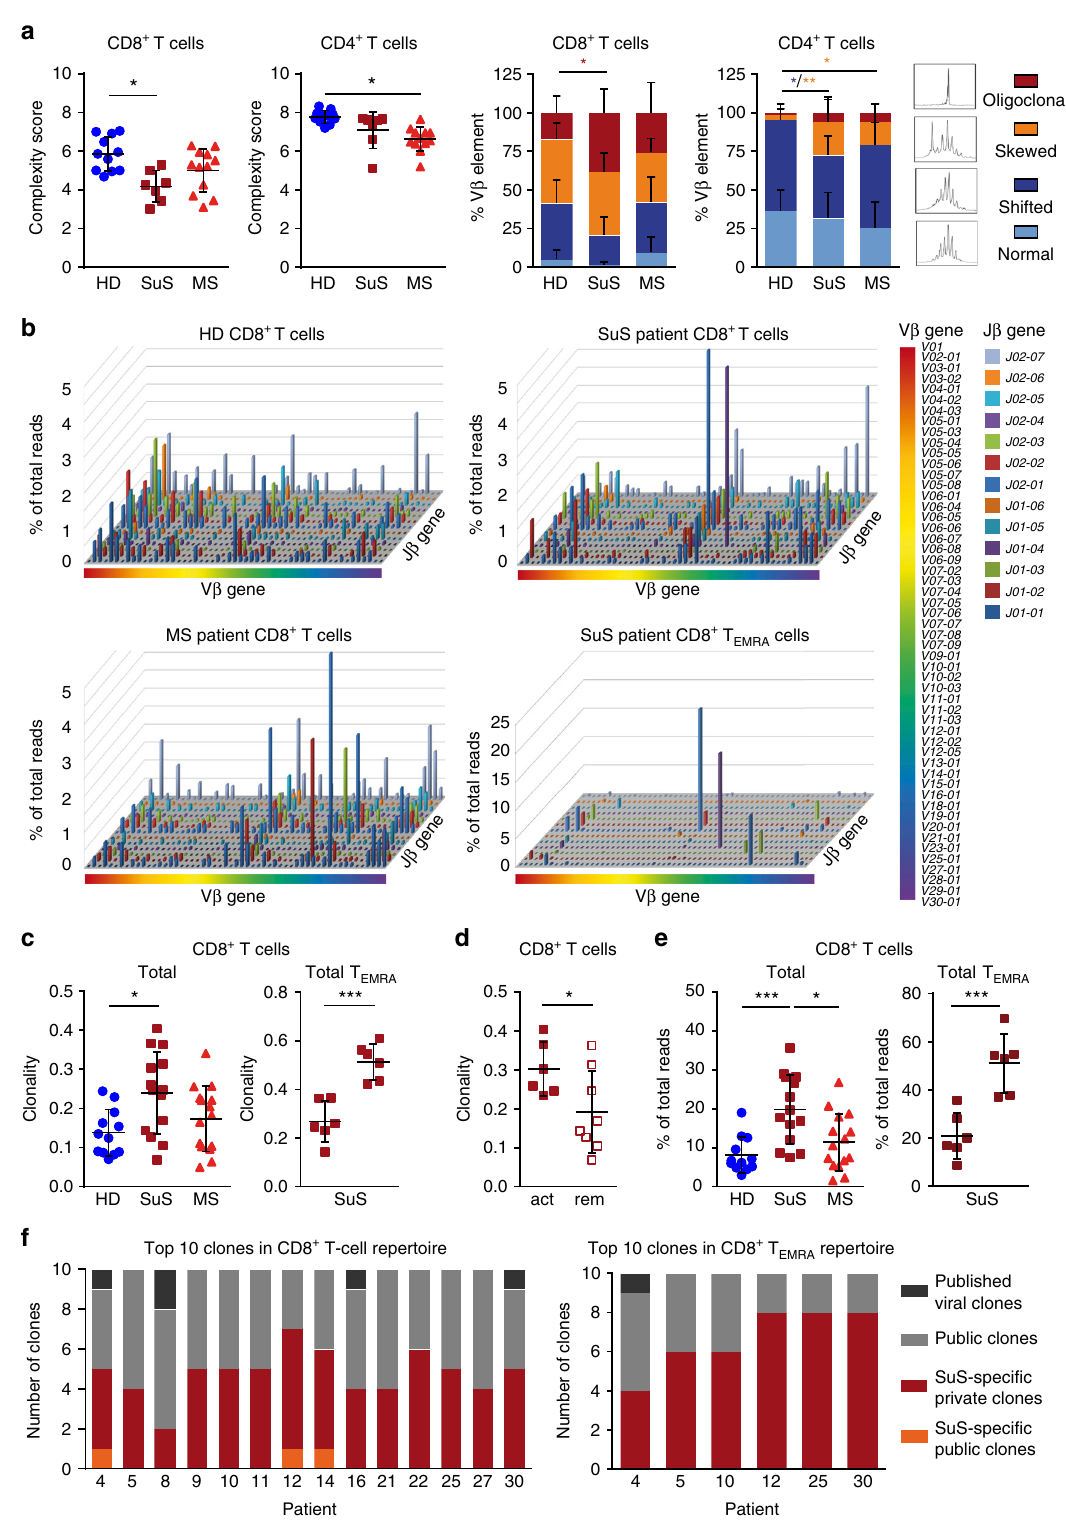
this end, we generated (Slco1c1-CreER T2 × Rosa26-Stop-HA)F1 mice, referred to as EC-HA + , (Supplementary Fig. 7a) that express the in fl uenza virus hemagglutinin (HA), as an endothelial neo-antigen. Owing to the promoter used in this model, antigen expression was found in ECs of the brain and retina 38 – 40 as well as inner ear 41,42 — the target organs in SuS but not in other tested organs (Supplementary Fig. 7b). We have fi rst assessed whether